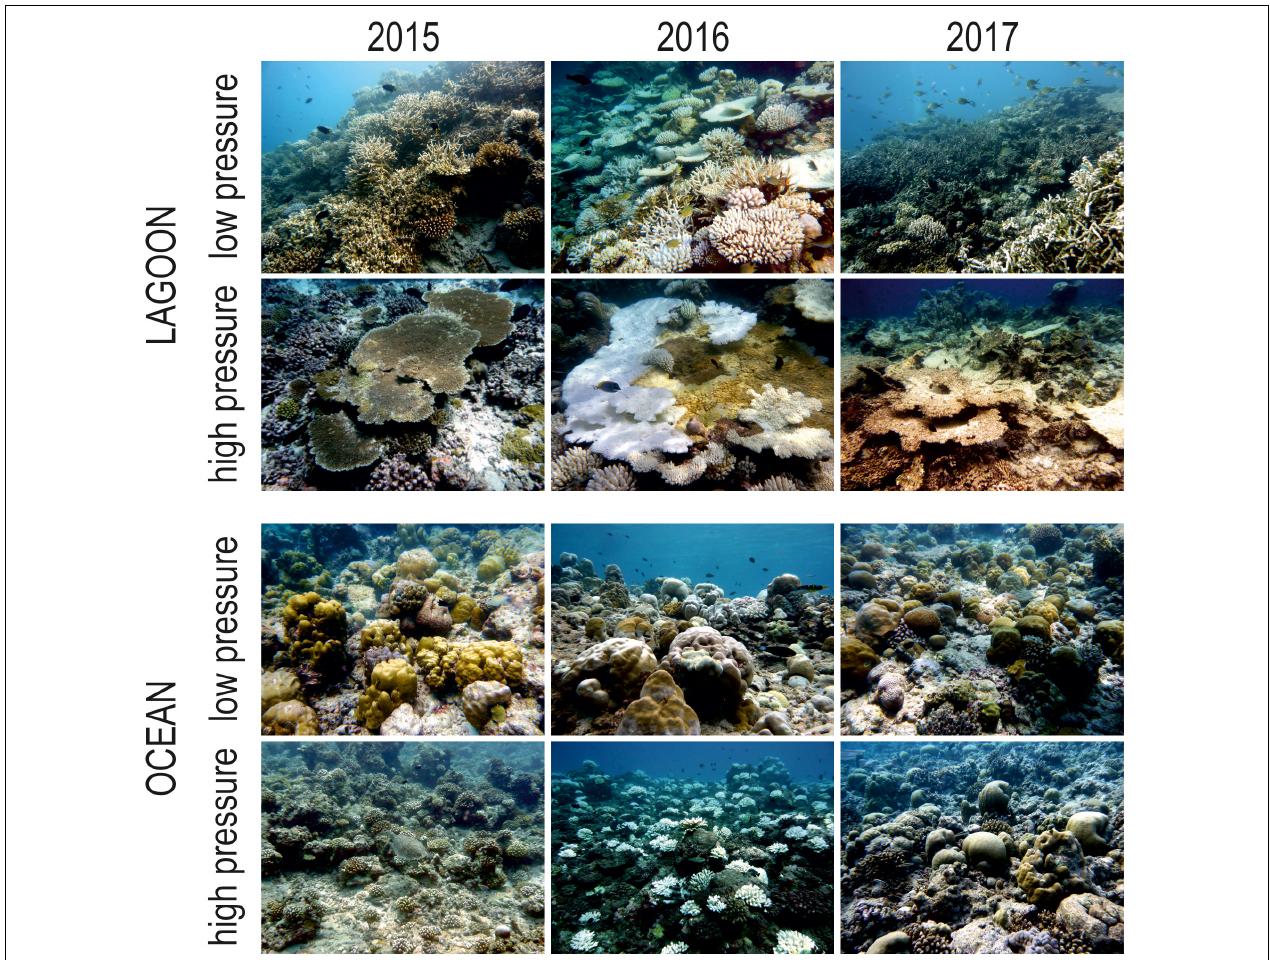
FIGURE 5 | Representative pictures of Maldivian lagoon and ocean reefs subjected to low and high human pressure in 2015, 2016, and 2017 (i.e., before, during, and after the 2016 mass bleaching event, respectively) at 5 m depth.